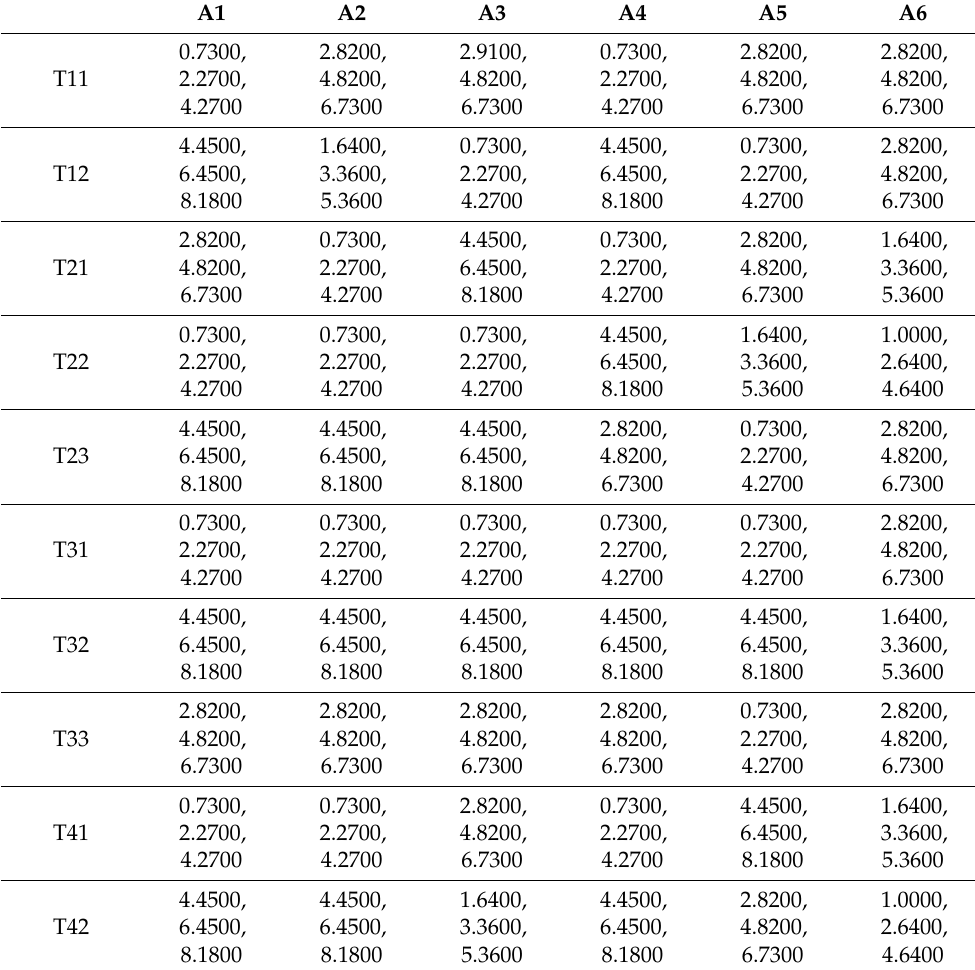
Table 14. Subjective cognition results of evaluators in linguistic